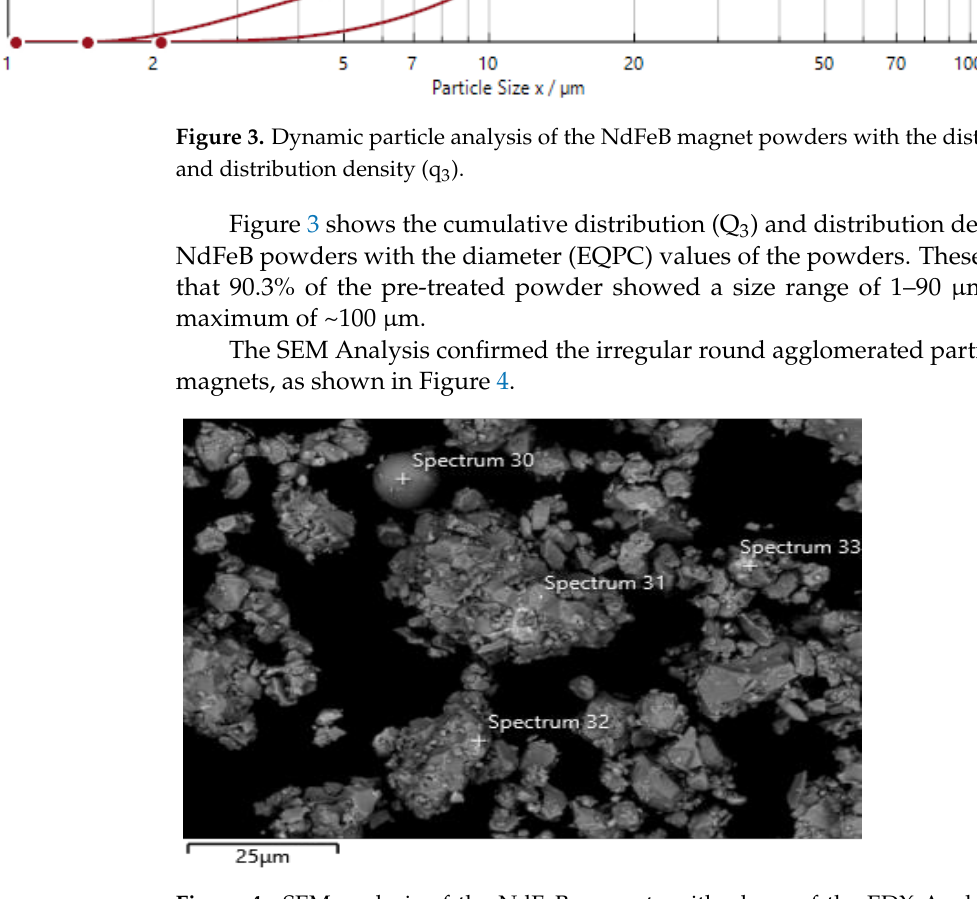
Figure 4. SEM analysis of the NdFeB magnets with places of the EDX Analysis (Spectrum 30, Spectrum 31, Spectrum 32 and Spectrum 33).